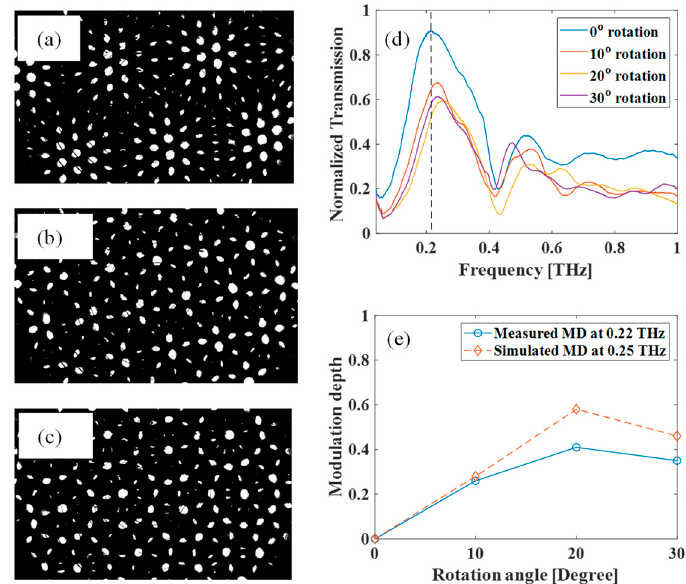
Figure 6. Moiré pattern image taken using 2f imaging system for ( a ) 10° rotation; ( b ) 20° rotation; ( c ) 30° rotation. ( d ) Experimental normalized transmission as a function of frequency for different rotation angles. ( e ) Obtained modulation depth in the case of simulation and measured findings as a function of rotation angles.